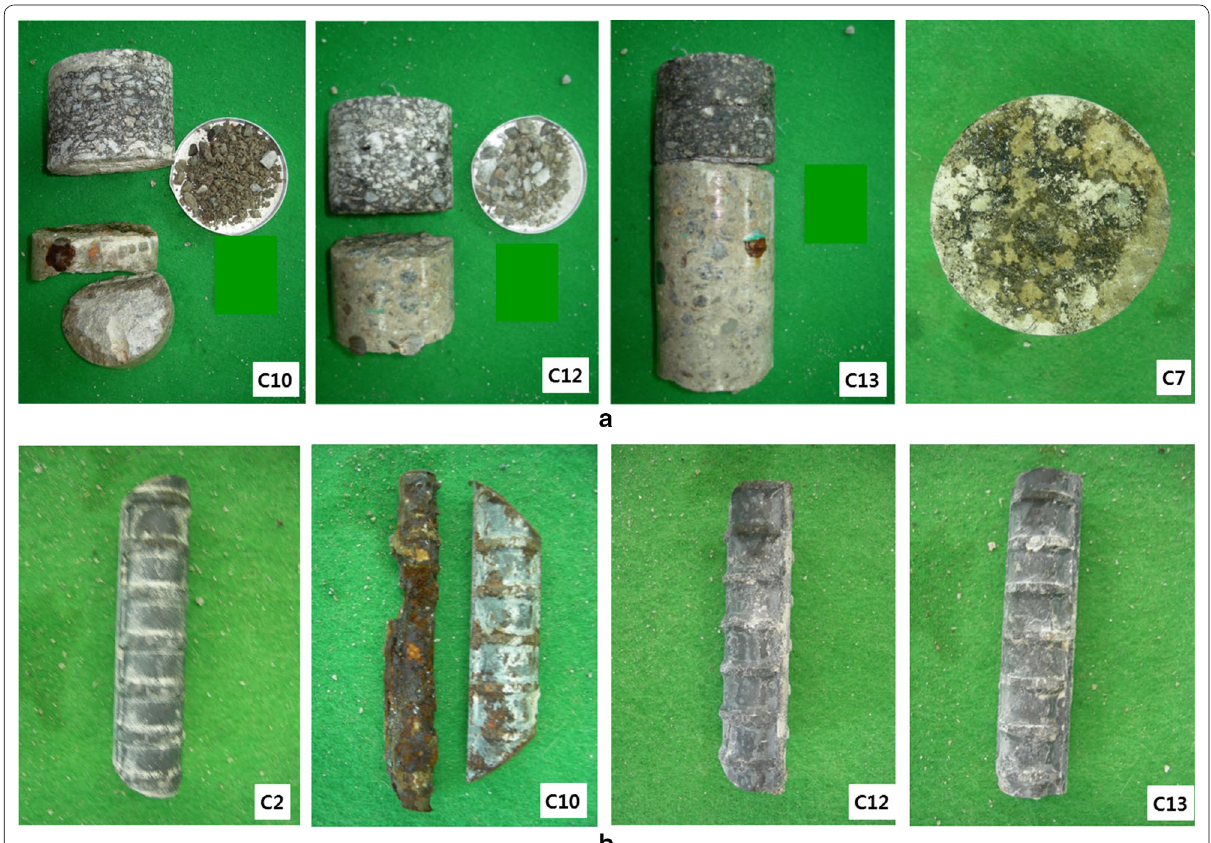
Fig. 5 Visual evaluation of deterioration of concrete and rebar through core samples; a major deterioration pattern and b rebar